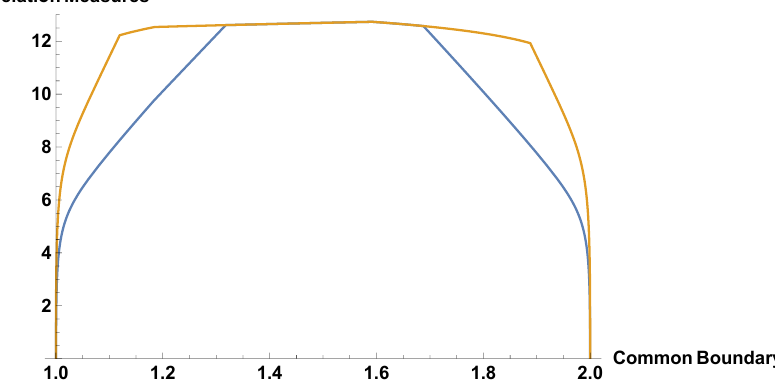
Figure 37 . Plot of correlation measures namely reflected entropy (yellow) and mutual information (blue) for two adjacent intervals A and B while the common boundary of the two intervals is shifted from one end point to the other in the bath BCFT 2 s. In the y-axis, the correlation measures are plotted after scaling over the central charge c of the BCFT 2 s. Here r I = 1 , r O = 2 , (cid:15) = . 0001 , β = . 1 , c = 500 , t = . 15 , S bdyb = 875 and S bdya = 850